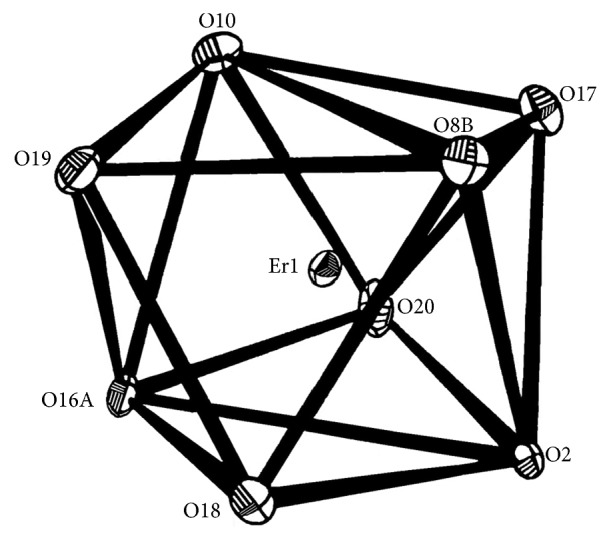
Coordination polyhedron structure of Er(III).